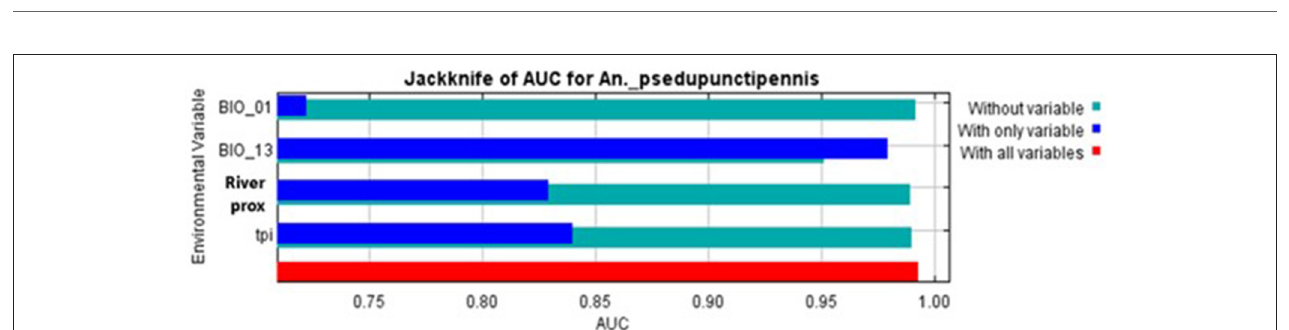
FIGURE 3 | Jackknife test model with variables BIO1, Bio13, river proximity, and topographic position index (TPI).